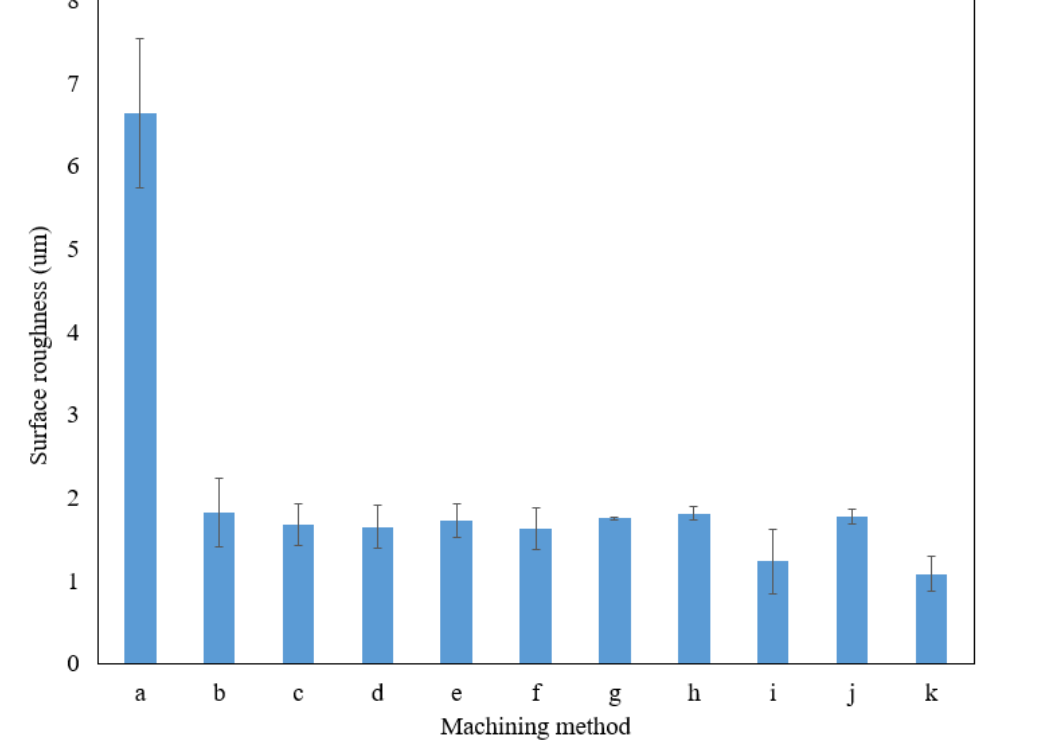
Figure 7. Rz value of the sidewall on a microfluidic channel of different machining methods and parameters. (a) Wire EDM; (b) 15 V, 15 vol.%, 10 mm; (c) 15 V, 20 vol.%, 20 mm; (d) 15 V, 25 vol.%, 30 mm; (e) 20 V, 15 vol.%, 20 mm; (f) 20 V, 20 vol.%, 30 mm; (g) 20 V, 25 vol.%, 10 mm; (h) 25 V, 15 vol.%, 30 mm; (i) 25 V, 20 vol.%, 10 mm; (j) 25 V, 25 vol.%, 20 mm; (k) 20 V, 20 vol.%, 10 mm (optimum parameters).